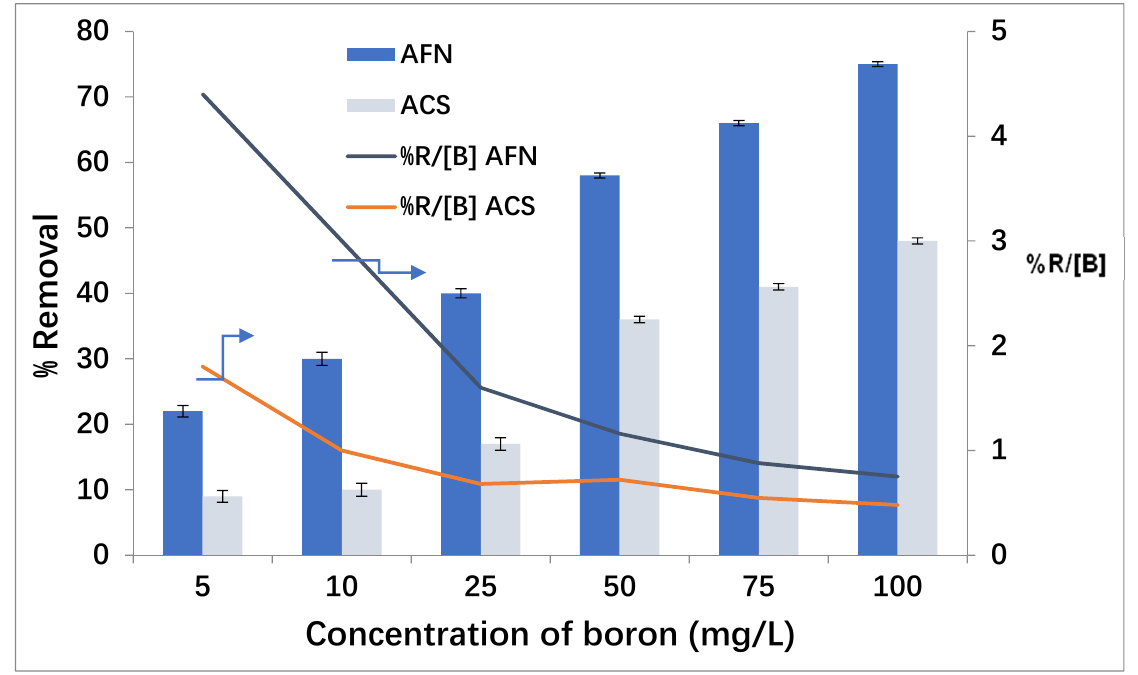
Figure 4. Effect of boron concentration in the feed compartment.